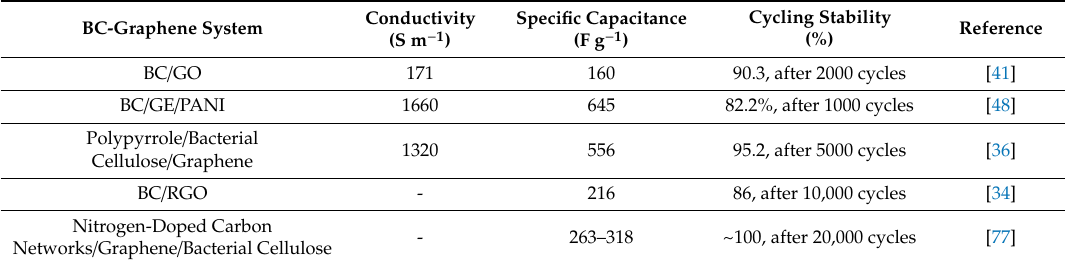
Table 3. Conductivity, specific capacitance and cycling stability of flexible electrodes prepared from BC-graphene nanocomposite